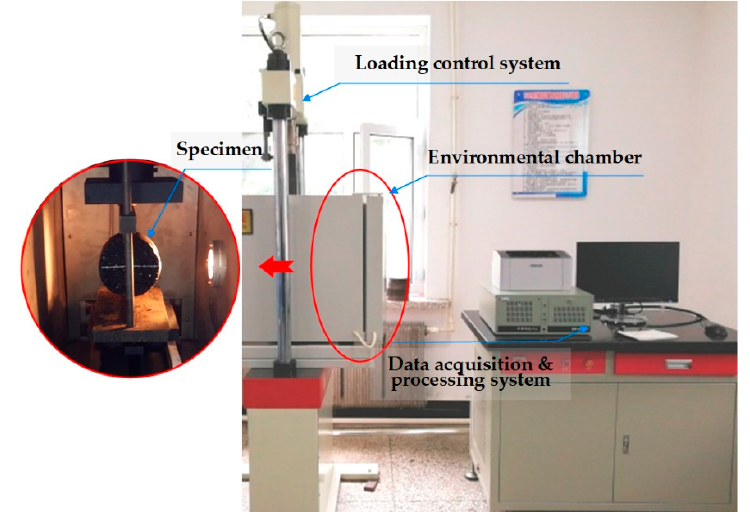
Figure 4. Low-temperature splitting test used in this paper.